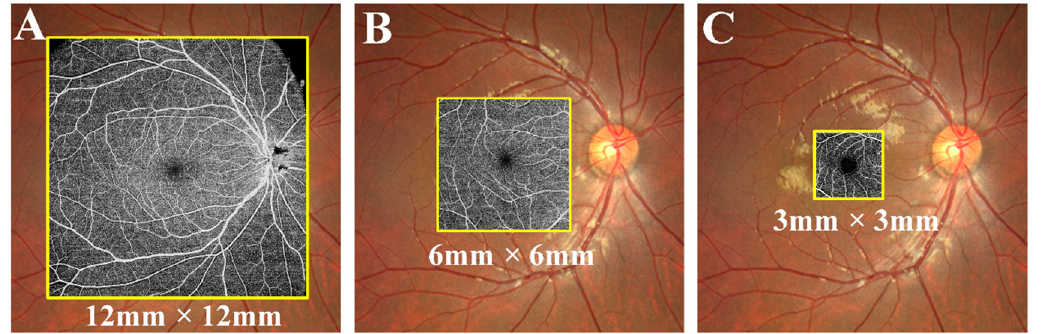
Figure 1. Examples of OCTA images with different ranges are shown in Figure 1. ( A ) Wide-field image of 12 mm × 12 mm; ( B ) OCTA image of 6 mm × 6 mm; ( C ) OCTA image of 3 mm × 3 mm. OCTA image of 12 × 12 mm; ( B ) OCTA image of 6 × 6 mm; ( C ) OCTA image of 3 × 3 mm. OCTA, OCTA, optical coherence tomographic optical coherence tomographic angiography.